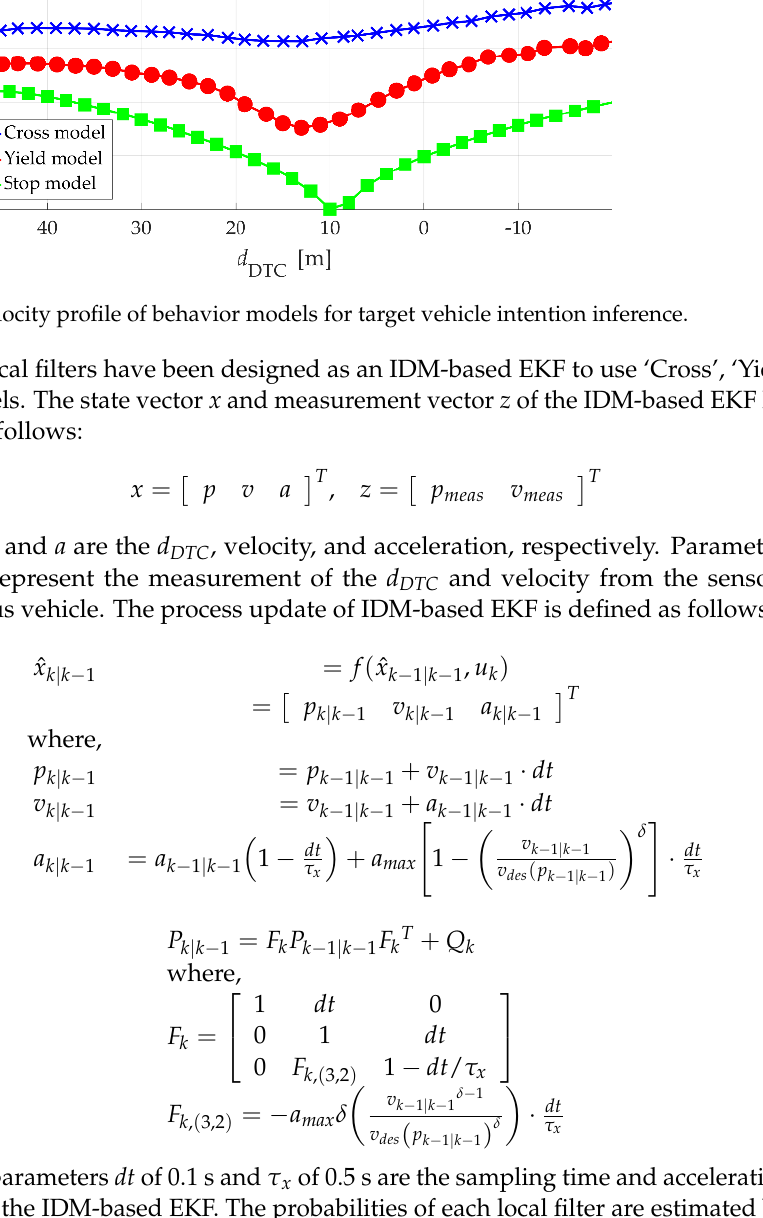
Figure 5. The measured and desired velocity profiles.